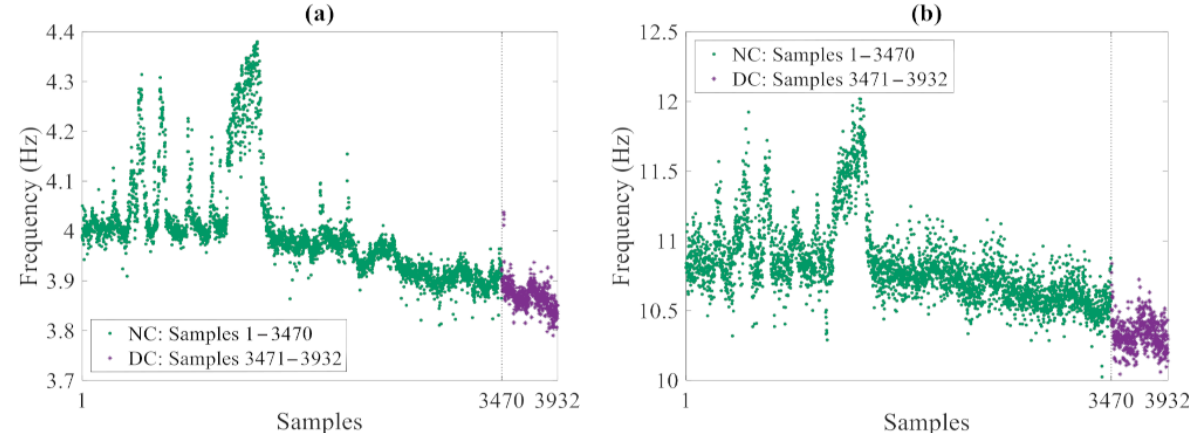
Figure 10. Z24 Bridge: time histories of the monitored vibration frequencies (NC: Normal Condition, DC: Damaged Condition), relevant to the ( a ) first and ( b ) fourth